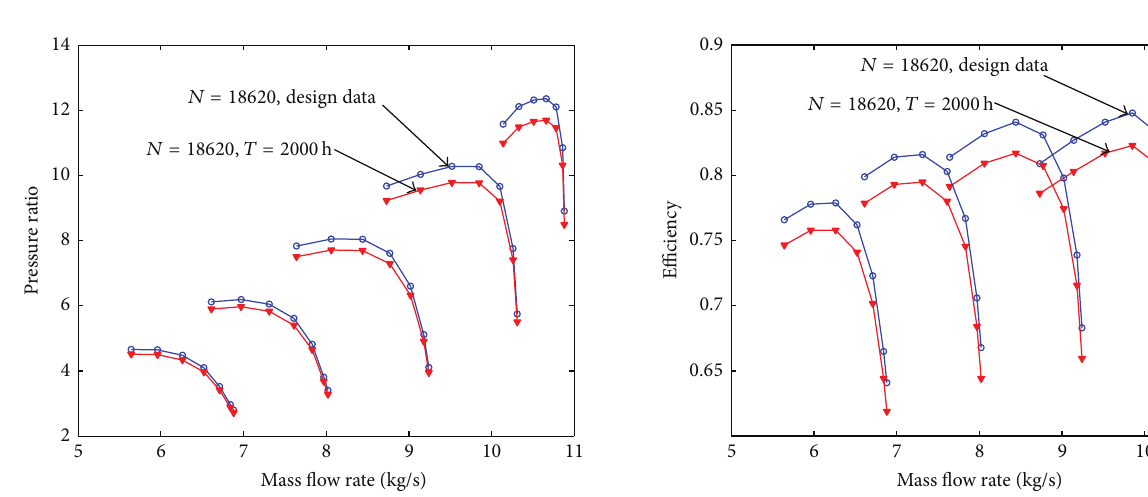
Figure 11: The efficiency curve in design and fouled condition when operating time is 2000 hours.